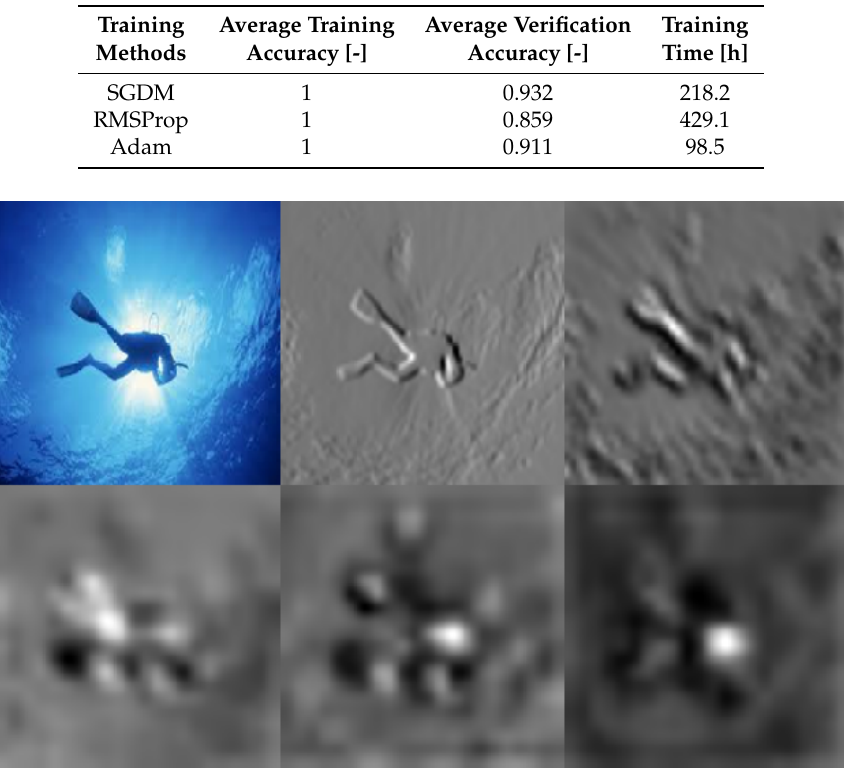
Table 2. The results of SGDM, RMSProp and Adam methods of training DLNN in the OCUV problem.